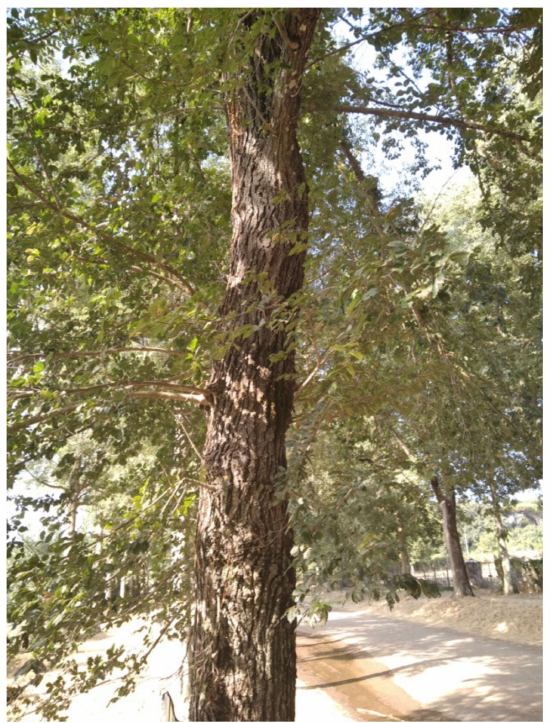
Figure 1. The study site in Oriolo Romano, central Italy. Photo by Luca